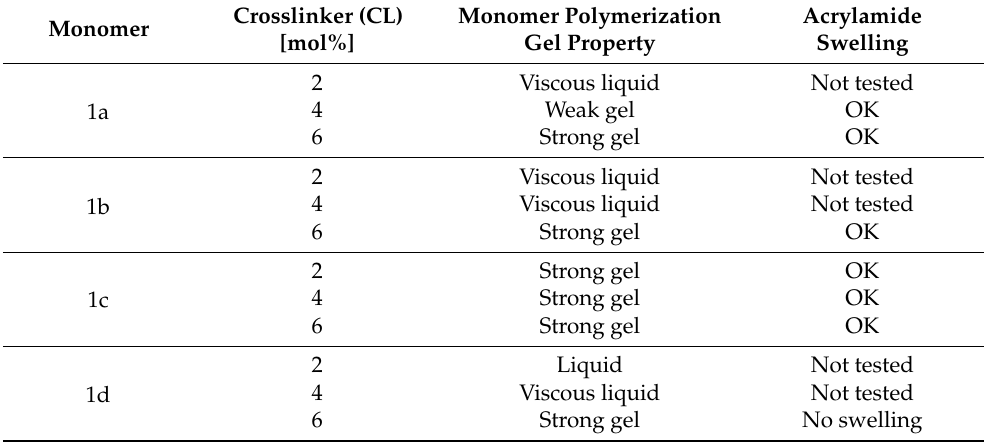
Table 1. Results of the polymerization experiment with different crosslinker concentrations.